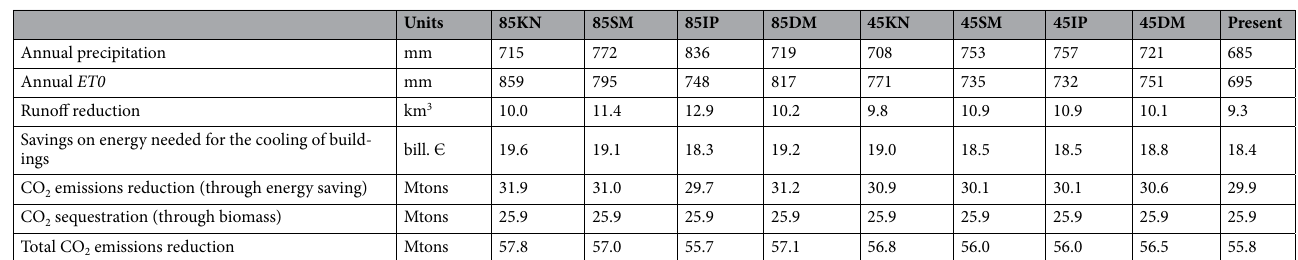
Table 1. Climatic descriptors and quantification of annual benefits at the European scale in the present and future climatic scenarios, assuming to green all roof surfaces, or 35% of the European impervious